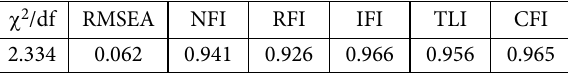
Table 7. Goodness-of-fit of the measurement